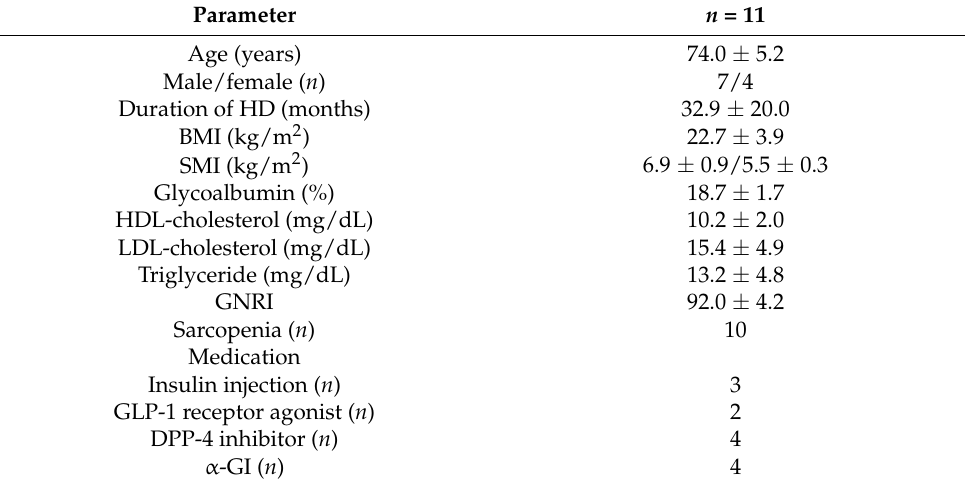
Table 1. Physical characteristics, duration of hemodialysis, and metabolic parameters of